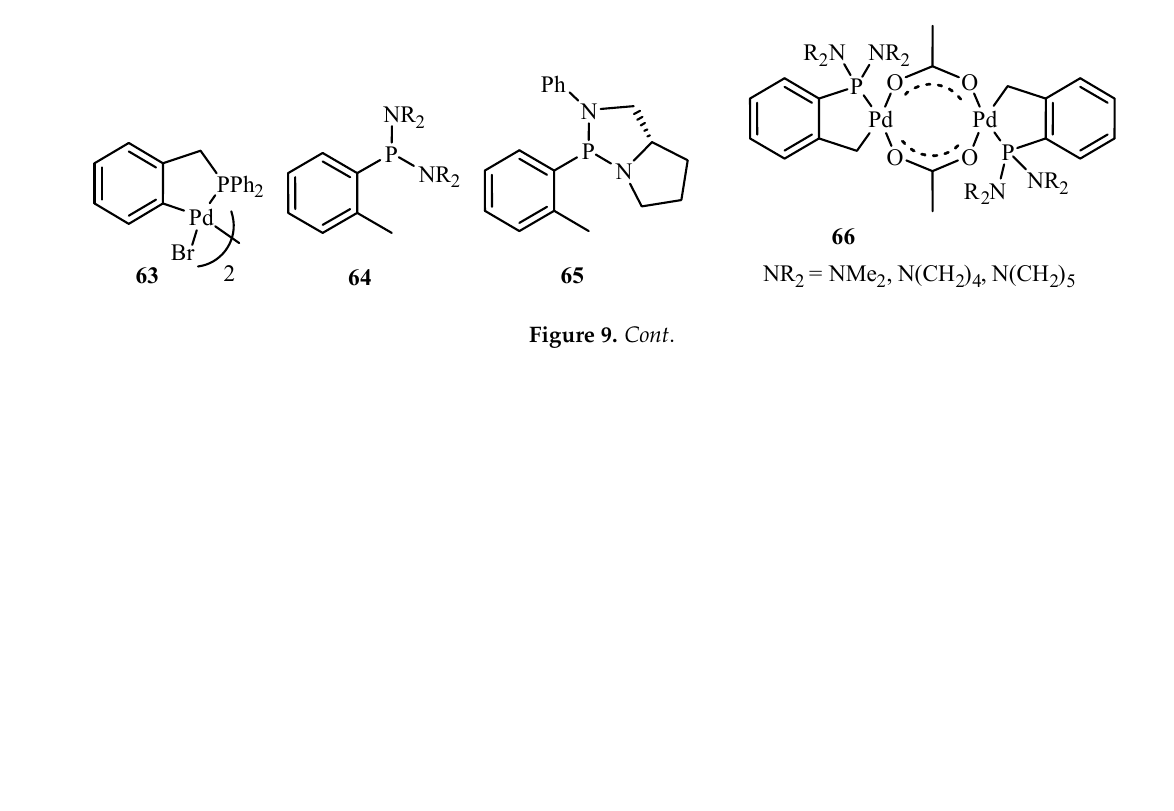
Figure 8. Palladium complexes with phosphorus and N ‐ heterocyclic carbene ligands reviewed by Herrmann et al. [19].